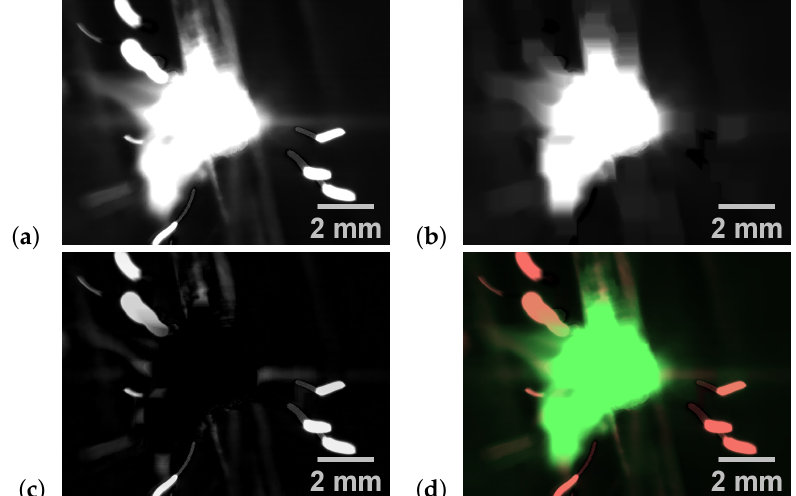
Figure 3. Gray-scale opening, ( a ) gray-scale image ( b ) process light ( c ) spatter ( d ) overlaid image with spatters colored in red and the process light in